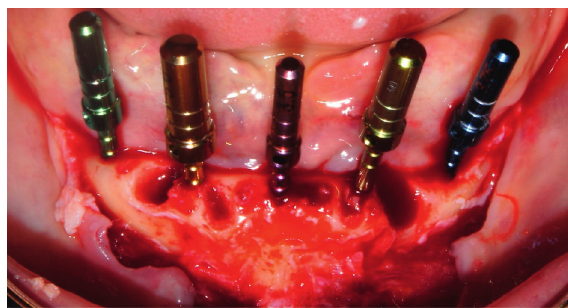
Figure 6: Test of parallelism of dental implants.